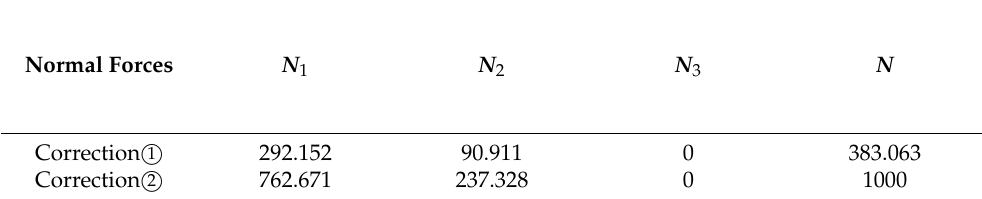
Table 7. Normal forces of discrete areas of constraint method ( T = 0 N, n =